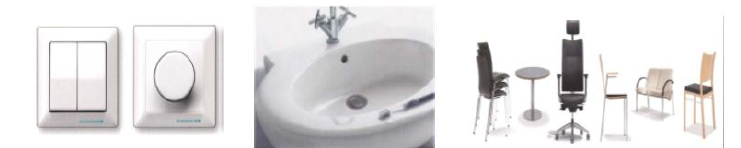
Figure 6. samples of the products can use nano silverparticles to be anti- bacterial (Hanafi,2012)